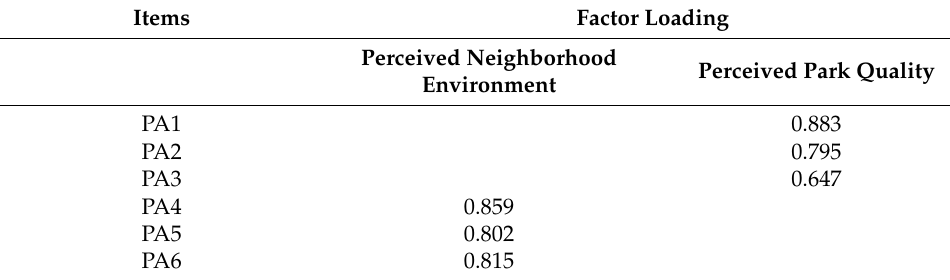
Table 6. Rotating component matrix of psychological accessibility. Items Factor